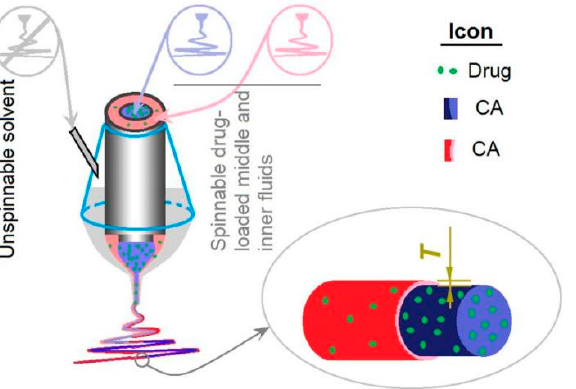
Figure 1. A schematic of the modified tri-axial electrospinning, in which unspinnable solvent is explored as an outer fluid for the smooth preparation of core–sheath nanofibers. T means thickness of the sheath section.